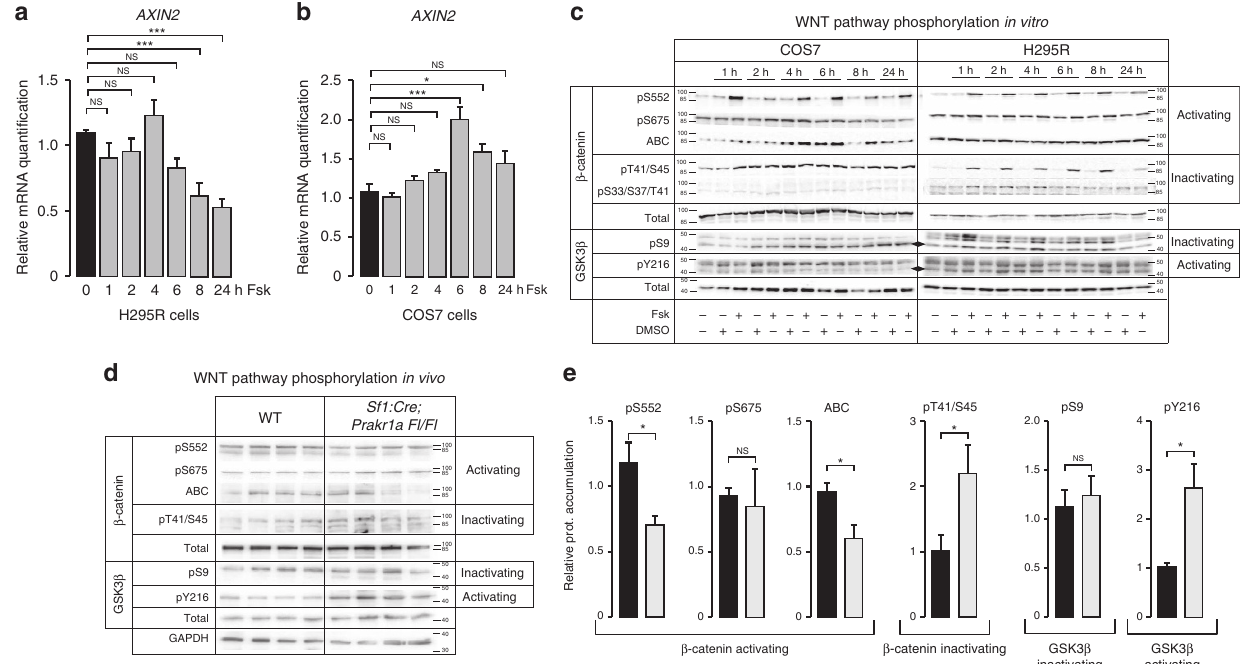
Figure 2 | Effect of PKA activation on downstream WNT pathway phosphorylation. ( a ) Forskolin represses AXIN2 expression in human adrenocortical H295R cells. Human H295R cells were treated with either vehicle (0, DMSO) or Forskolin 10 (cid:2) 5 M (Fsk) for 1 to 24h and AXIN2 expression was analysed by RT–qPCR. Bars represent mean expression in at least three independent experiments (in triplicate) ± s.e.m. Statistical analyses were performed by one-way ANOVA followed by Dunnett’s multiple comparison test. ( b ) Forskolin activates AXIN2 expression in COS7 cells. COS7 cells were treated with Forskolin for 1 to 24h and AXIN2 expression was analysed as described in a . ( c ) Differential phosphorylation of b -catenin and GSK3 b in COS7 and H295R cells. COS7 and H295R cells were treated as in a . Proteins were extracted and subjected to western blot analysis with antibodies to phospho/dephospho- b -catenin, phospho-GSK3 b or the corresponding total proteins. b -catenin phosphorylations/dephosphorylations were sorted as activating (pS552, pS675, active beta-catenin) and inactivating (pT41/S45 and pS33/S37/T41). GSK3 b serine 9 phosphorylation (pS9) results in its inactivation. GSK3 b tyrosine 216 phosphorylation (pY216) results in its activation. Phospho-GSK3 antibodies recognize phospho-GSK3 b arrowheads, and phospho-GSK3 a (top band) ( d ) Phosphorylation of b -catenin and GSK3 b in response to constitutive PKA activation in vivo . Activating and inactivating phosphorylations of b -catenin and Gsk3 b were analysed in adrenal protein extracts from four wild-type and 4 Sf1:Cre;Prkar1Fl/Fl mice as described in c . ( e ) Constitutive activation of PKA inhibits activating phosphorylations and stimulates inactivating phosphorylations in vivo. Graphs show pooled quantification of phospho-specific signals in d and Supplementary Fig. 3, representing a total of nine wild-type and nine Sf1:Cre;Prkar1aFl/Fl mice. These were normalized to quantification of total corresponding proteins. Statistical analyses were performed with Student’s t -test. * P o 0.05; *** P o 0.0005; NS, not